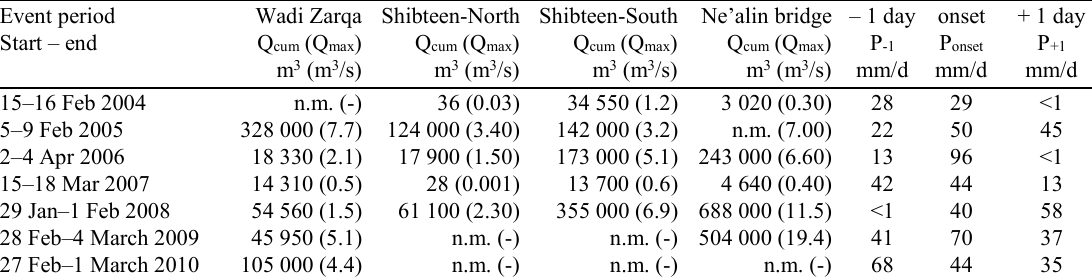
Table 2 Major annual runoff events at the four Wadi Natuf gauging stations (road culverts and bridges). Cumulative amounts of event flow in m 3 . In brackets: peak discharge rates in m 3 /s. Daily rate of area rainfall, one day prior, during and after the onset of the event. Incomplete event measurements are not